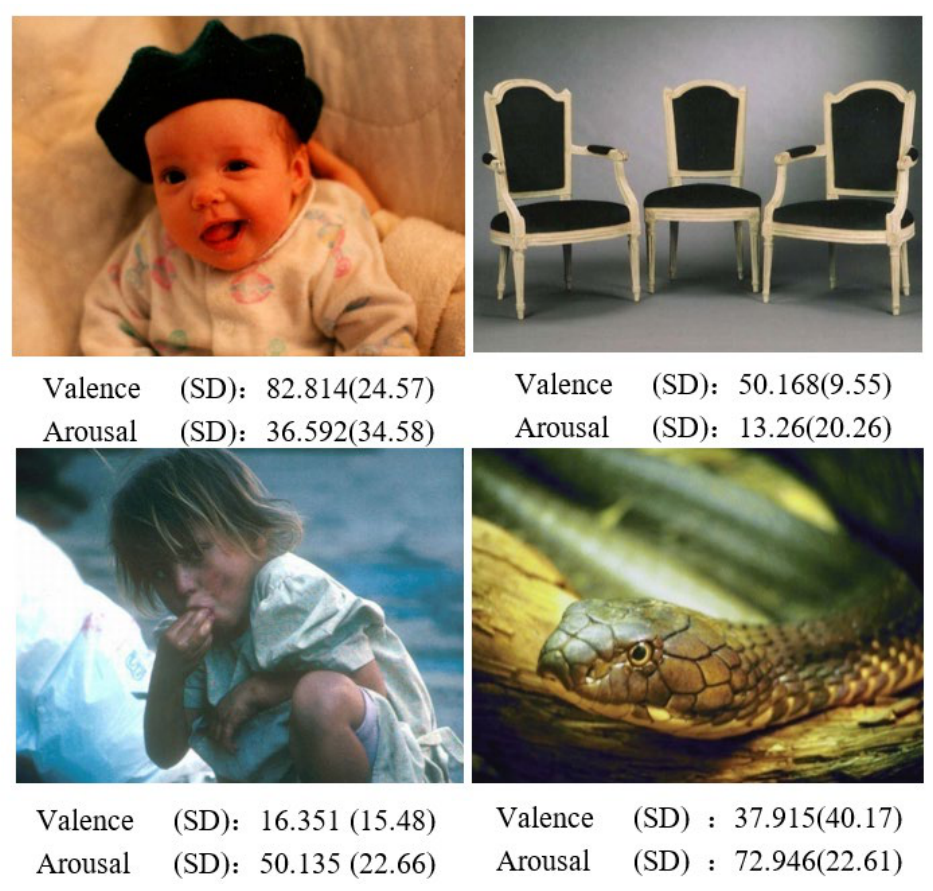
Figure A3. 4 pictures randomly selected from GAPED 730 pictures.